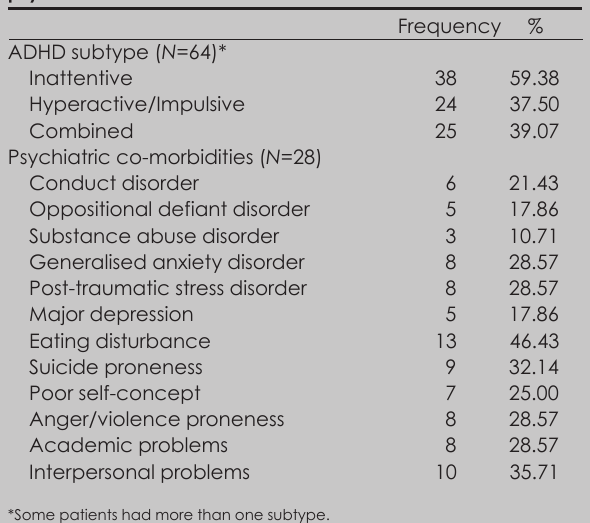
Table II reflects the frequencies of ADHD subtypes currently evident in the adolescent respondents based on their guardians’/parents’ responses on the SNAP-IV, as well as the adolescents’ current Table II. Frequency distribution for ADHD subtypes and psychiatric co-morbidities Frequency